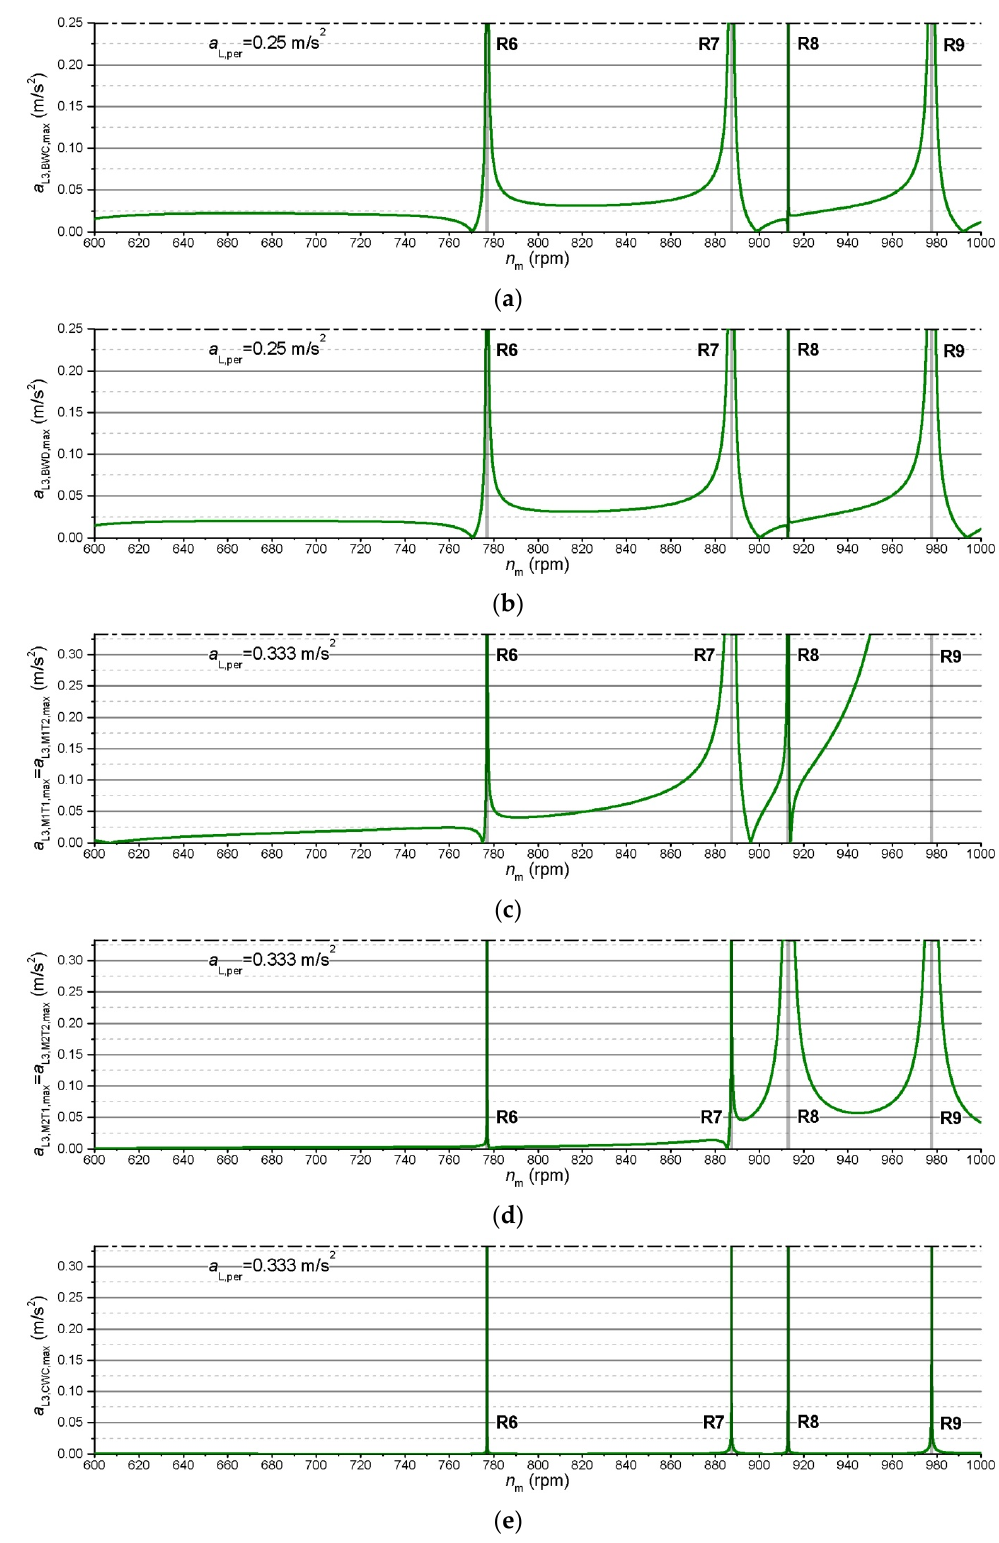
Figure 9. Response to the third harmonic of excitation—maximal lateral accelerations of the referent points of the slewing superstructure: ( a ) BWC; ( b ) BWD; ( c ) M1T1 and M1T2; ( d ) M2T1 and M2T2; ( e ) CWC.